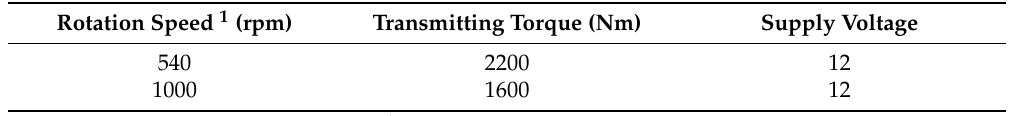
Table 1. Data for clutch